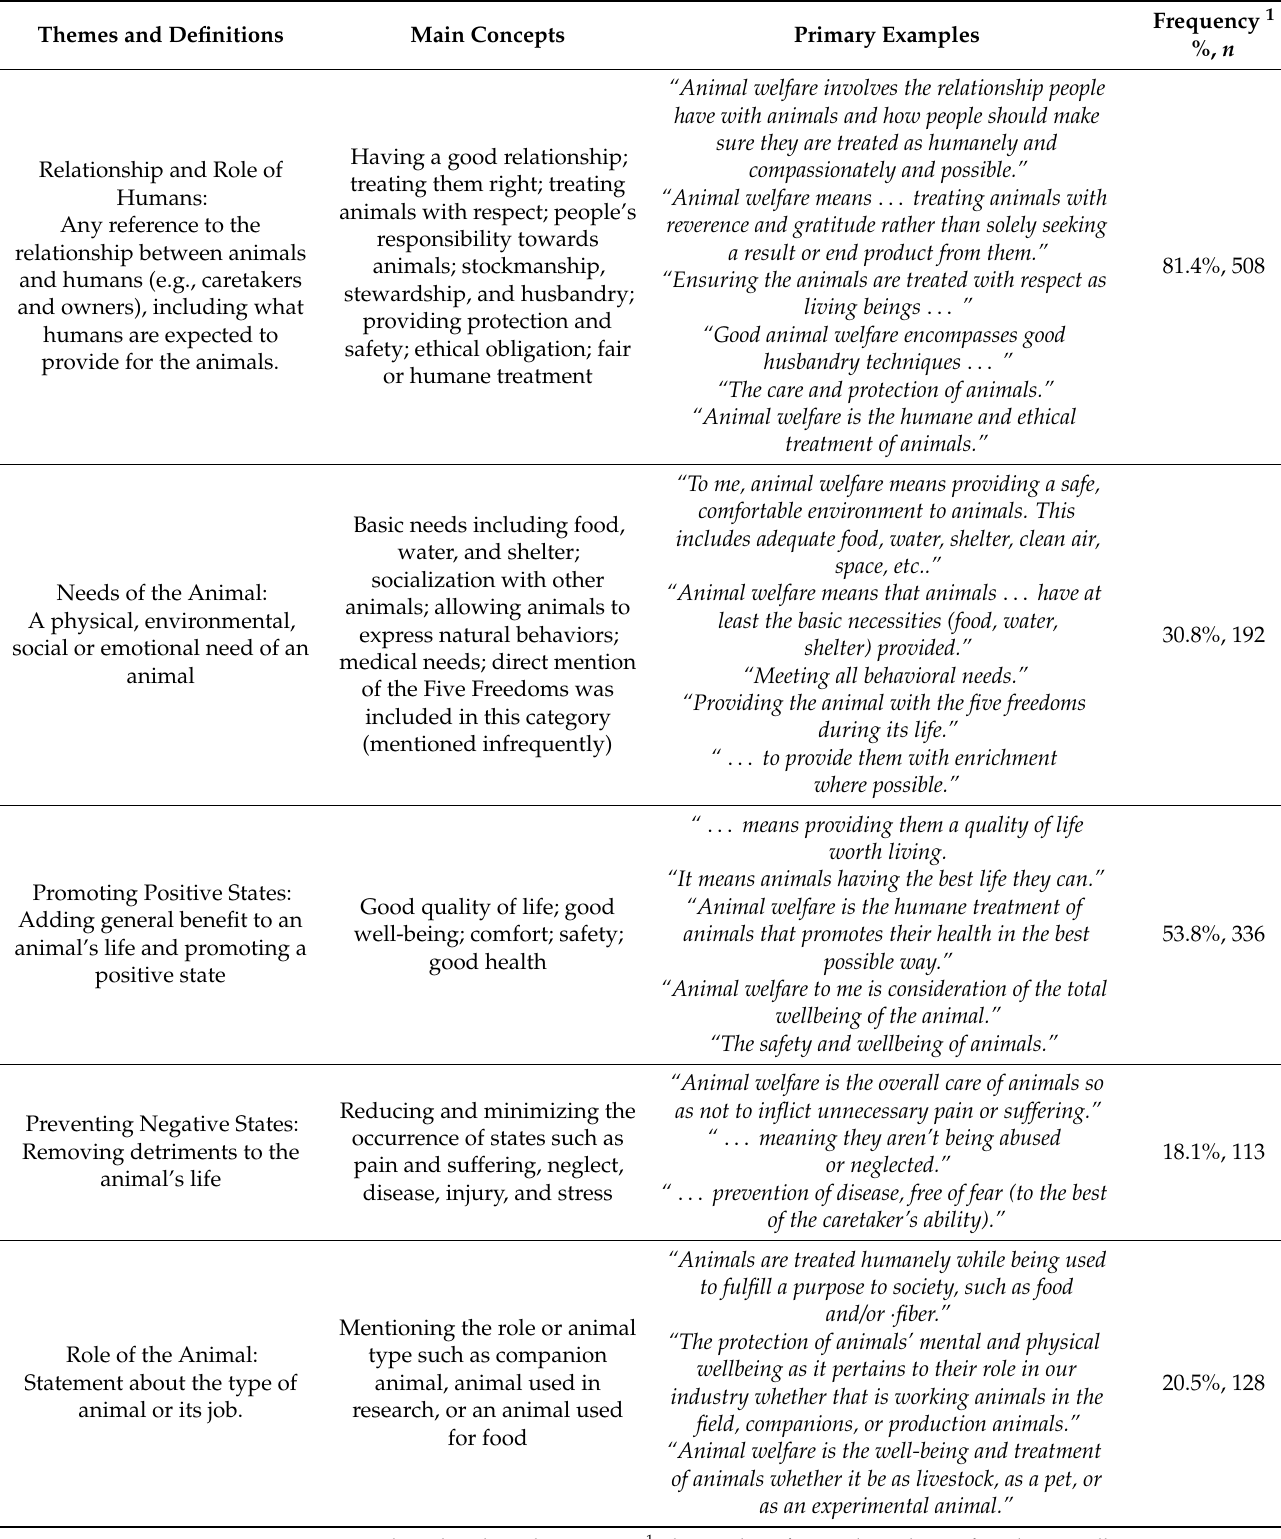
Table 4. Theme definitions, main concepts within each theme, and a sample of quotations